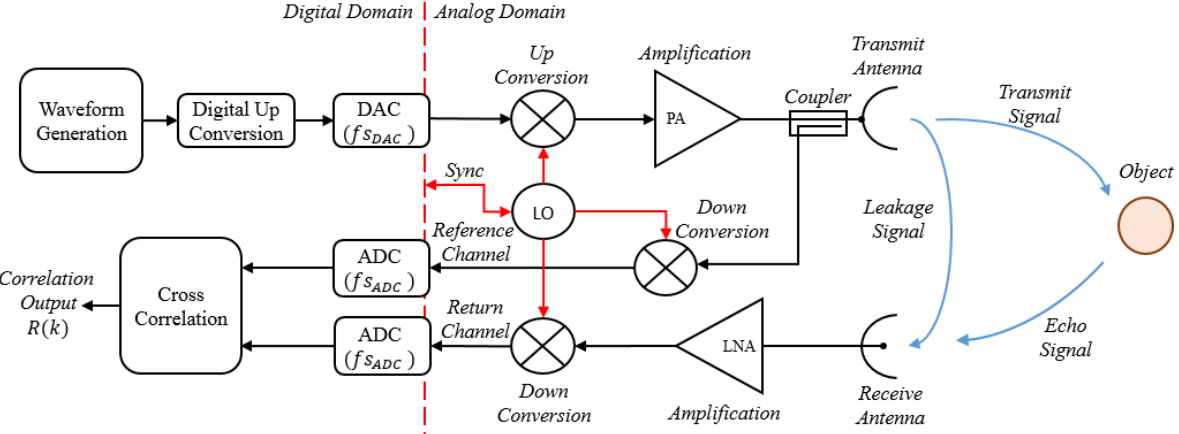
Figure 1. Noise radar block diagram.